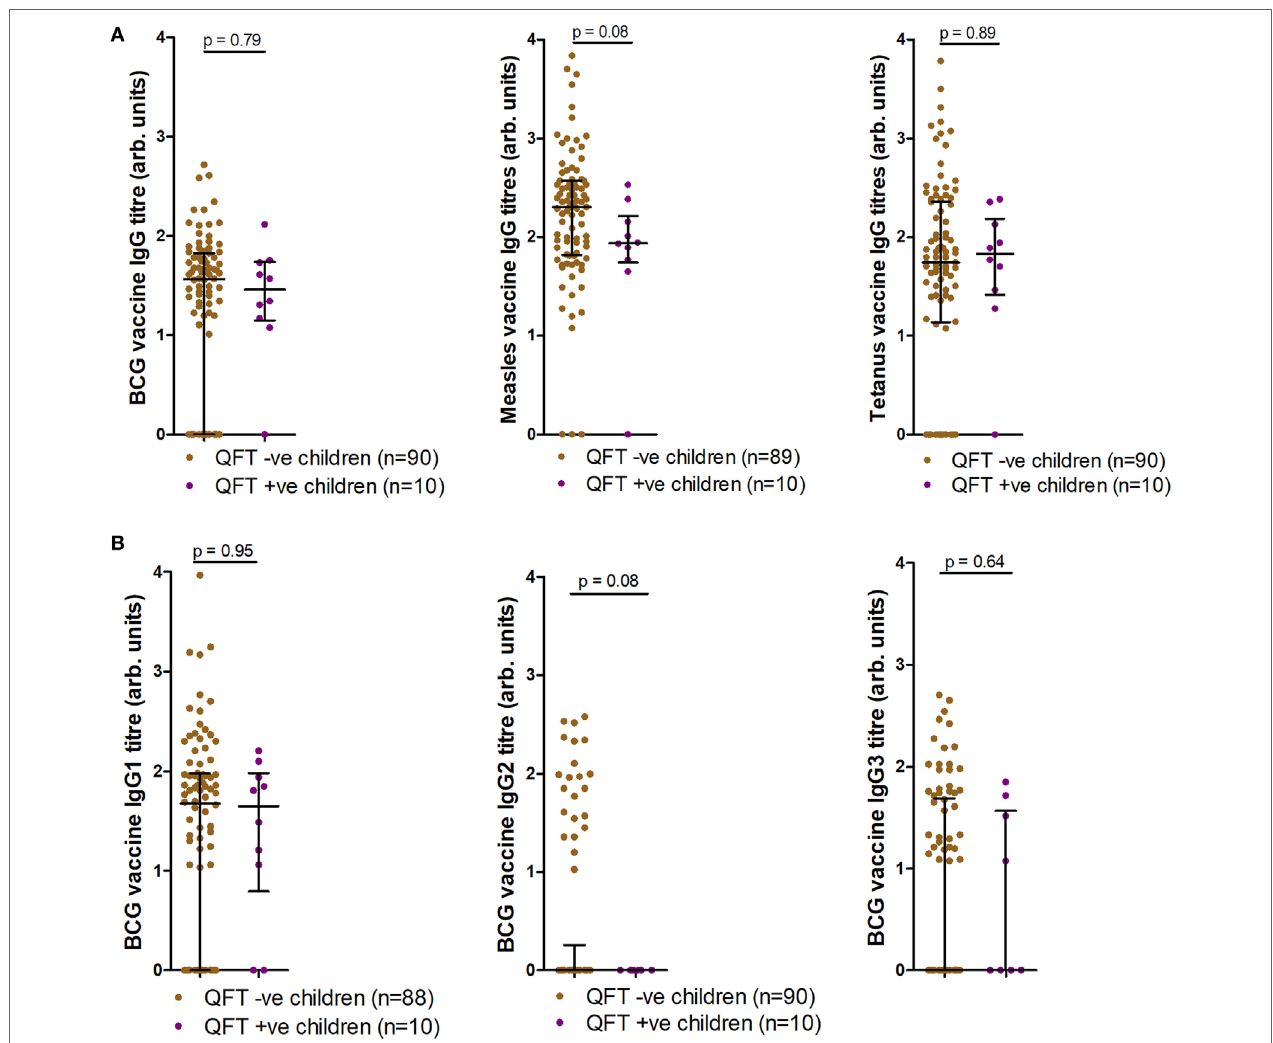
FigUre 4 | Antibody responses at tuberculosis investigation to childhood vaccines. Anti-Bacille Calmette-Guérin (BCG), measles, and tetanus IgG titers (a) , as well as anti-BCG IgG1, IgG2, and IgG3 titers (B) as measured by enzyme-linked immunosorbent assay and stratified by QFT result. One sample was excluded in the anti-measles IgG analysis (a) (participants had not received measles vaccination). Two fewer samples reported for BCG IgG1 (B) due to a lack of sample availability. Antibody titers are presented as arbitrary values. Comparisons were assessed for significance by the Mann–Whitney